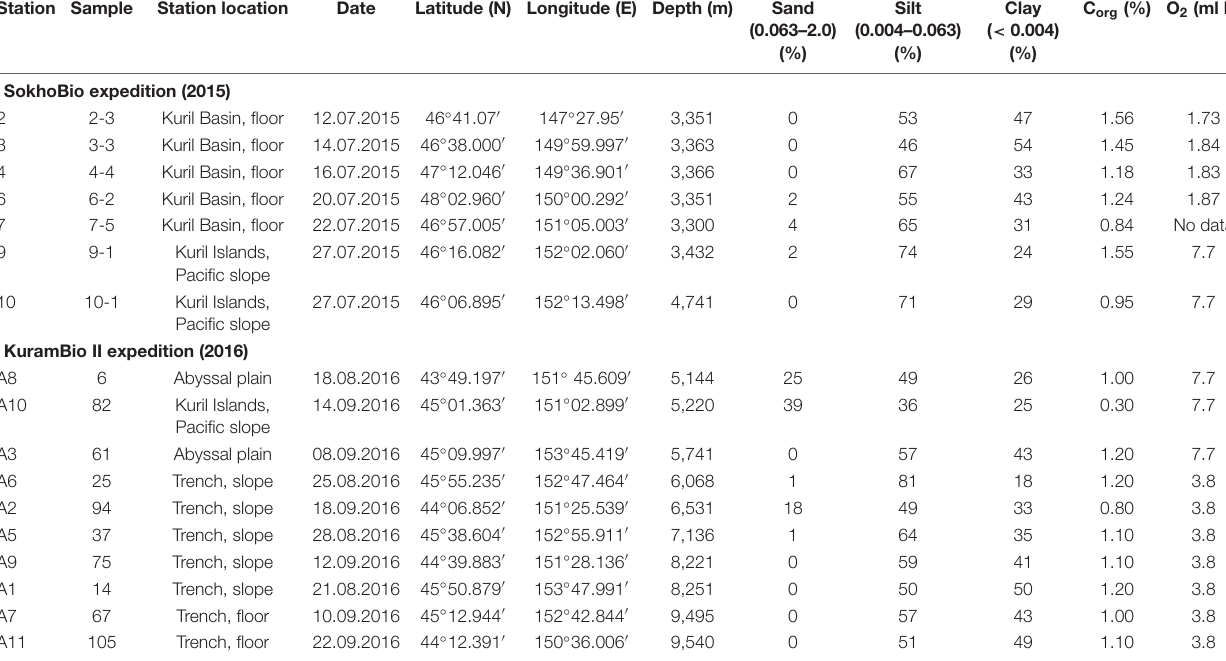
FIGURE 1 | A map of stations sampled in the abyssal zone of the Kuril Basin (Sea of Okhotsk) and abyssal and hadal zones of the Kuril-Kamchatka Trench area by the SokhoBio expedition (2015) (red circles) and KuramBio II expedition (2016) (yellow circles). TABLE 1 | Position and depth of box-corer samples and environmental data at the stations of the SokhoBio and KuramBio II expeditions in the Kuril Basin (Sea of Okhotsk) and the Kuril-Kamchatka Trench area (Pacific Ocean). Station Sample Station